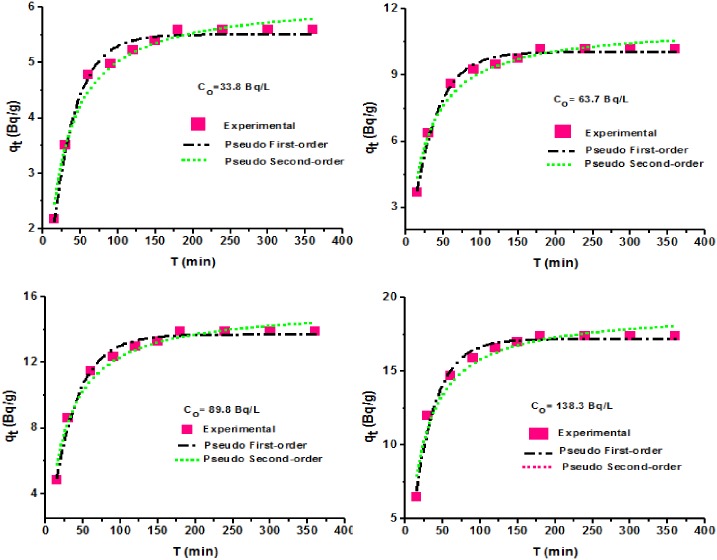
Adsorption kinetic models for 109Cd adsorption by PPy/SD composite.